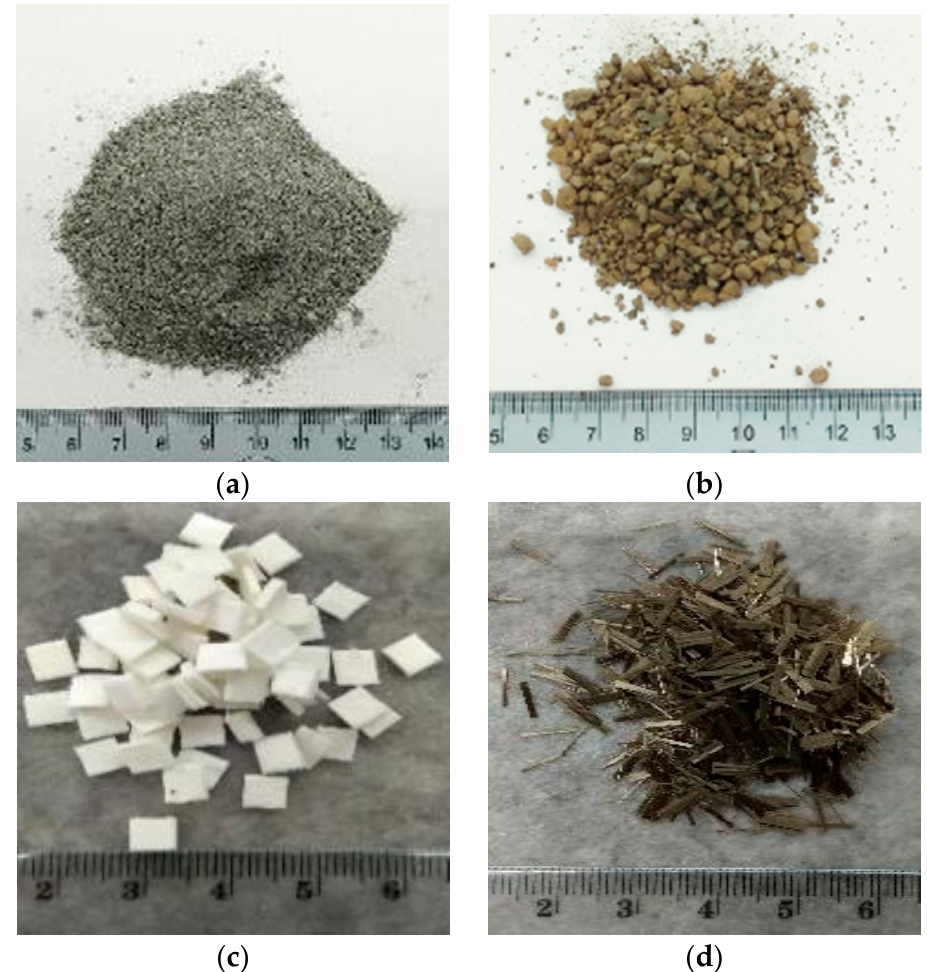
Figure 1. Appearance of raw materials including ( a ) De-S slag, ( b ) carbonated BOF slag, ( c ) cellulose and ( d ) basalt fibers.